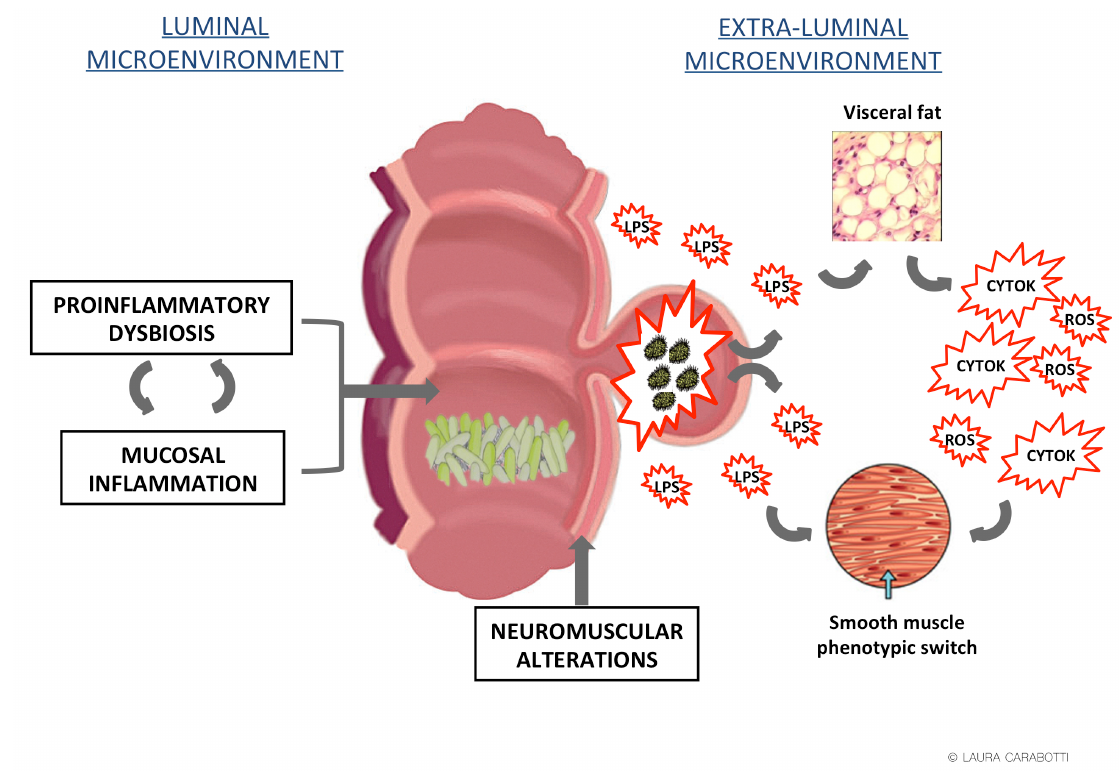
Figure 1. Pathogenic unifying hypothesis. CYT, cytokines; LPS, lipopolysaccharide; ROS, reactive oxygen